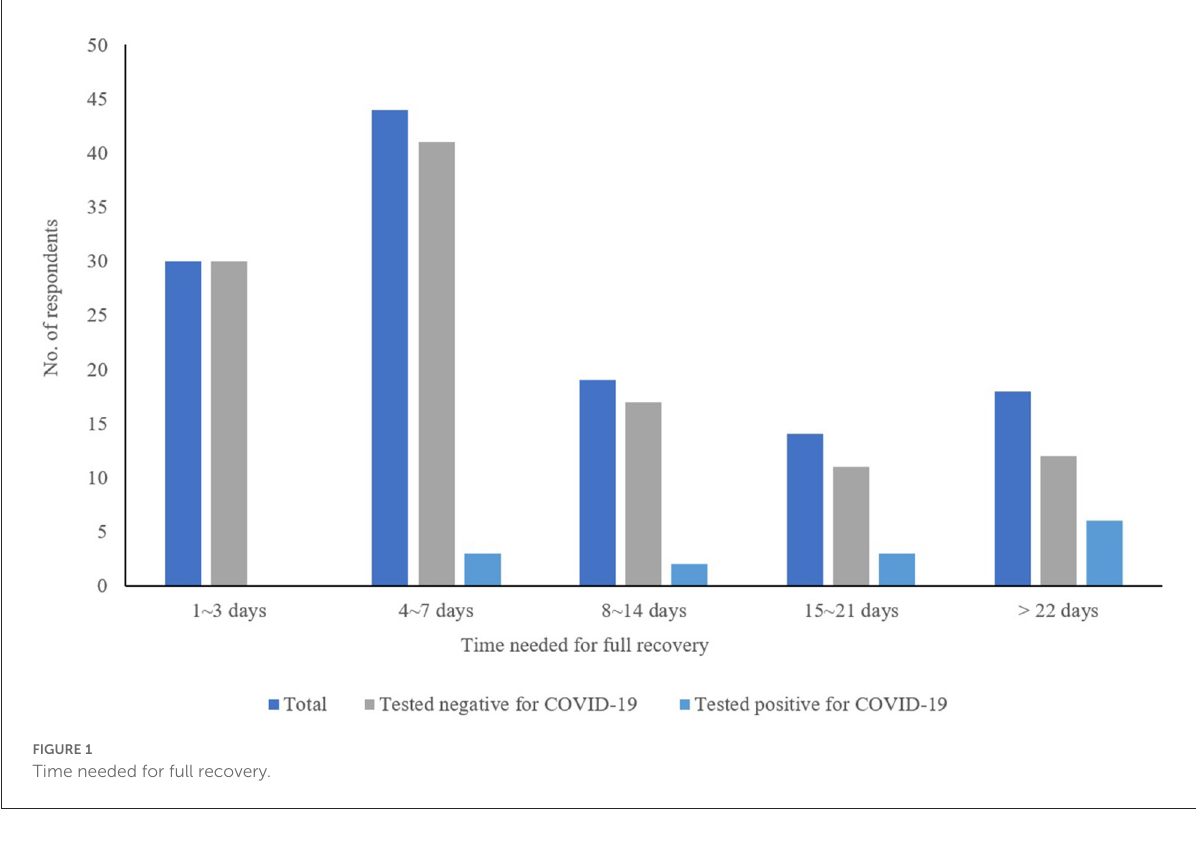
TABLE 5 Mental health conditions of survey respondents based on